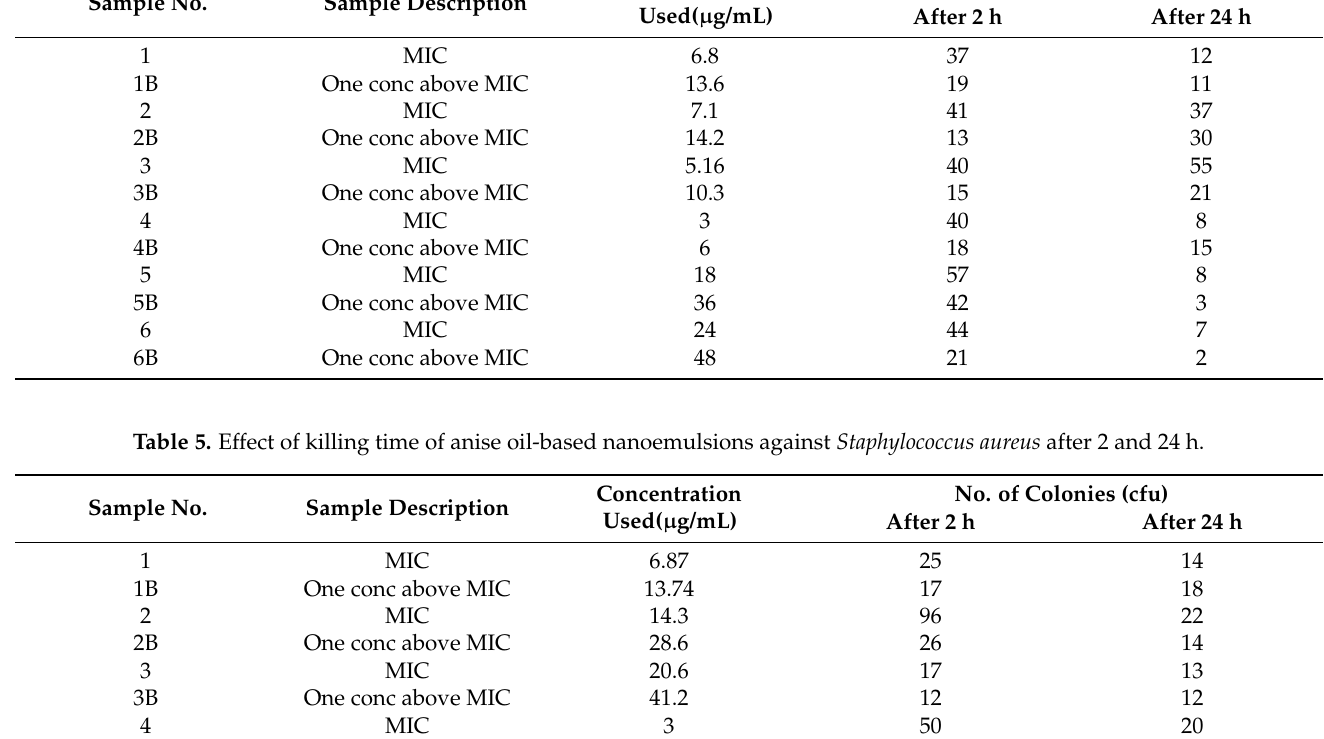
Table 4. Effect of different anise oil-based nanoemulsion concentrations on the mortality of Staphylococcus aureus after 2 and 24 h. Sample No.